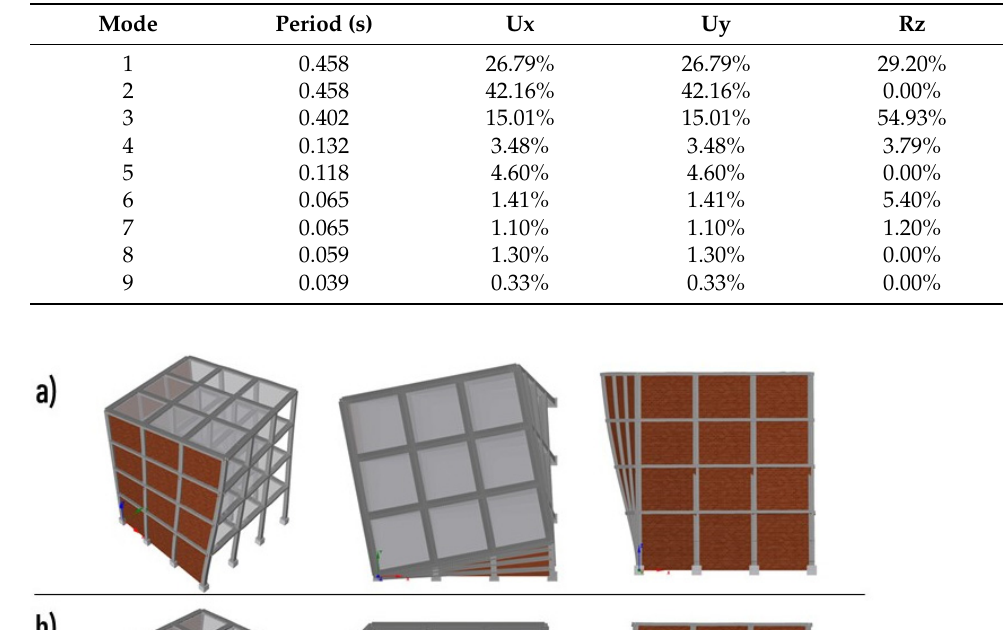
Table 4. Dynamic parameters with masonry infill panels included in the model.